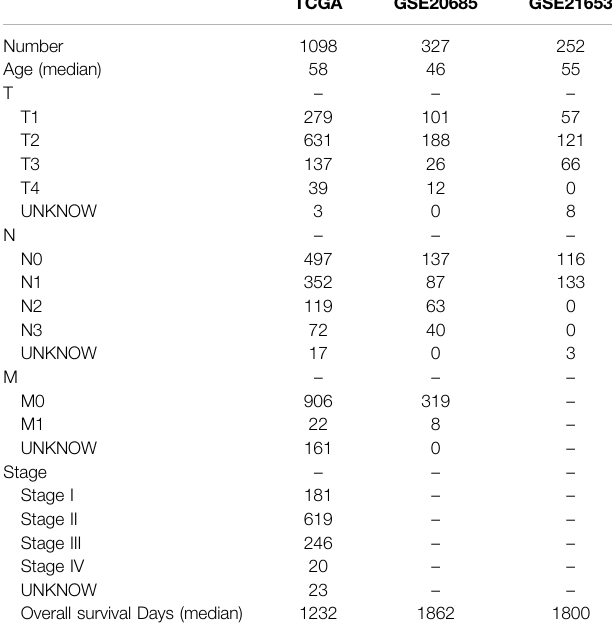
TABLE 1 | Data of all